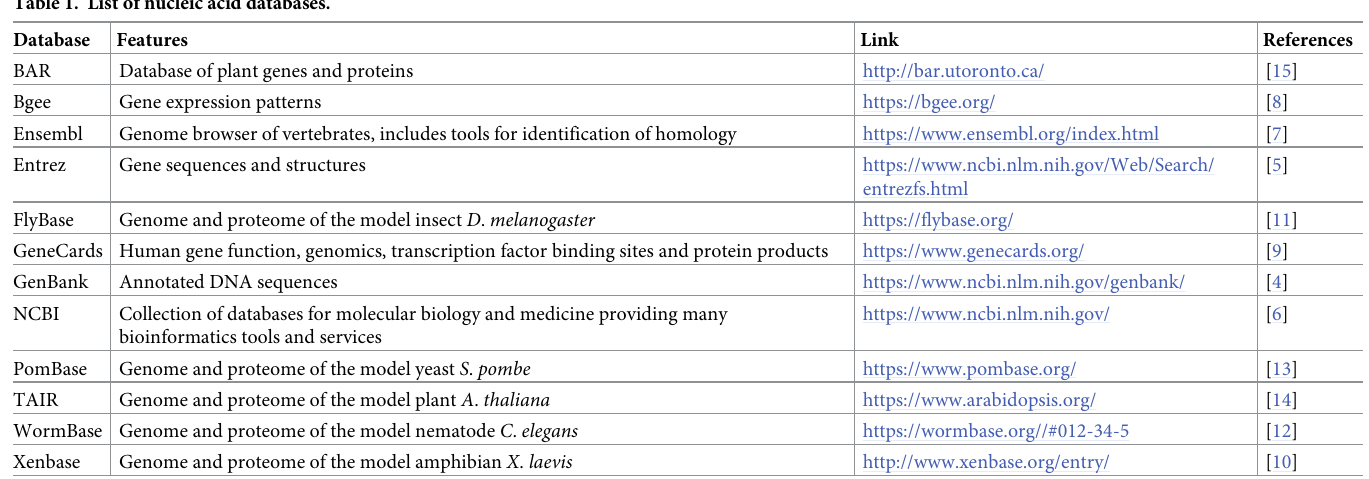
Table 1. List of nucleic acid